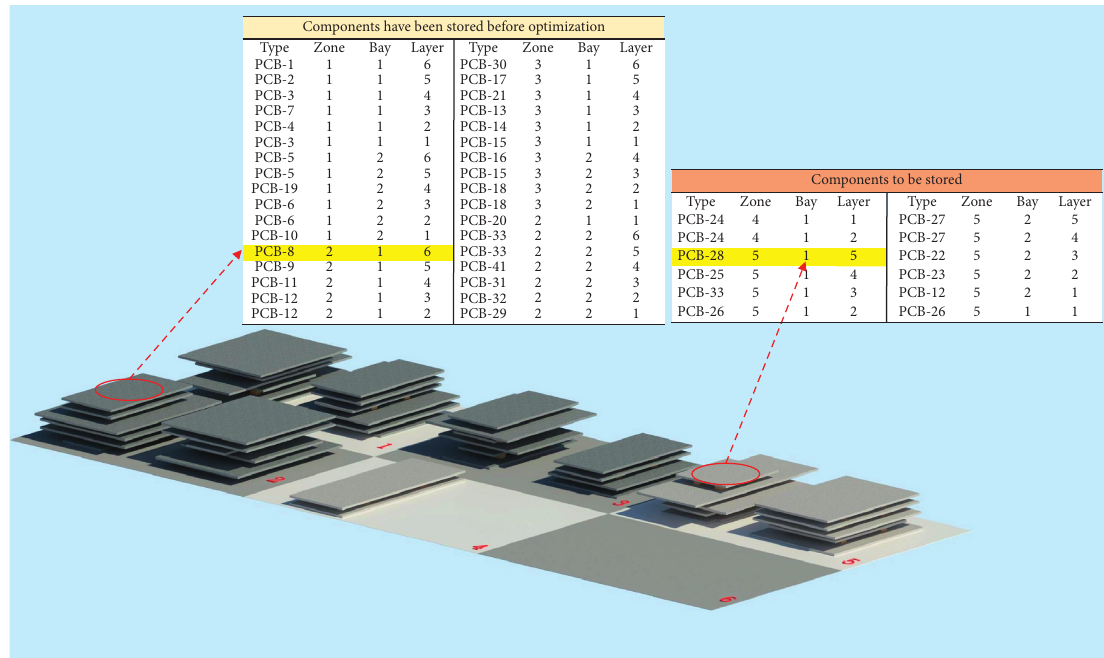
Figure 12: BIM of the storage yard after